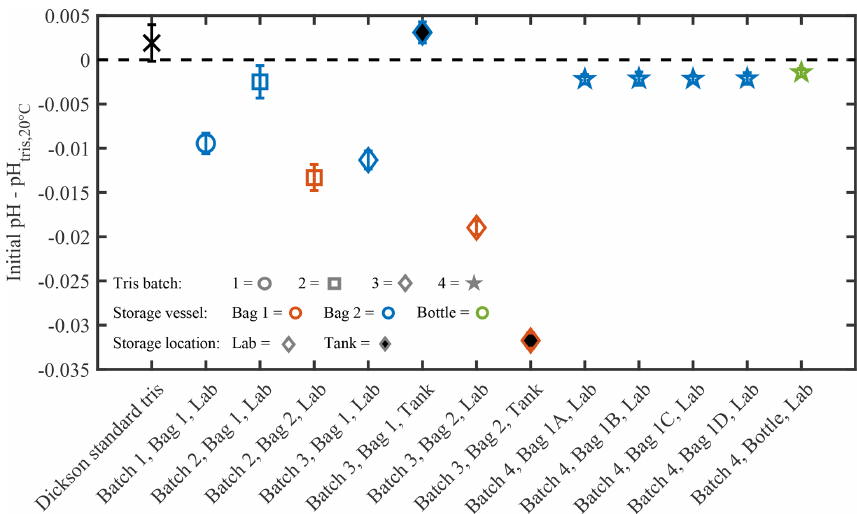
Figure A2. The initial pH residual of each tris bag or bottle measured in this experiment. The initial pH is reported as a residual from the calculated pH at 20 ◦ C. The initial pH was measured directly for tris batch 4 and extrapolated for tris batches 1–3. Additionally, two bottles of Dickson standard tris (show by the black “X”) were measured on 12 October 2018. The zero black dashed line is the calculated pH of tris at 20 ◦ C, based upon the measured reagent concentrations (DelValls and Dickson, 1998).